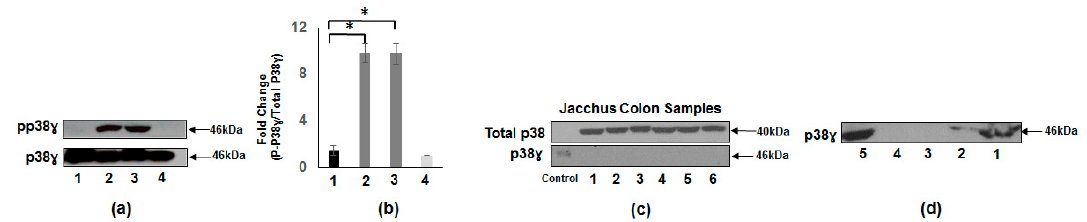
Figure 2. Presence of p38 γ and pp38 γ in preclinical and human tissue. ( a ) Whole tissue extracts from normal subject, CTT liver, and two derived from human cancerous colorectal tissue were prepared and subjected to SDS-PAGE and Western blot analysis using specific antibodies to pp38 γ . Equal loading was confirmed using antibodies against p38 γ . Normal subject (lane 1), CRC patients (lane 2, lane 3), and CTT liver (lane 4). ( b ) Densitometric values (means ± SEM) expressed as ratio of pp38 γ / p38 γ . * p value < 0.001. ( c ) Whole tissue extracts prepared from common marmoset (CM- C. jacchus ) colon tissues (lanes 1–6) not at risk representing a negative control, in contrast CM small intestinal ileum are potentially at risk and a positive control (doxorubicin treated breast cancer cell line) were all similarly subjected to SDS-PAGE and Western blot analysis using specific antibodies to p38 and p38 γ . None of the CM tissues have p38 γ but all express total p38 ( α and β ) ( n = 6). ( d ) Whole tissue extracts prepared from di ff erent organs of common marmoset, liver (lanes 1 and 2), gall bladder (lane 3), colon (lane 4), and ileum (lane 5) were subjected to SDS-PAGE and Western blot analysis using specific antibody to p38 γ ( n = 2).